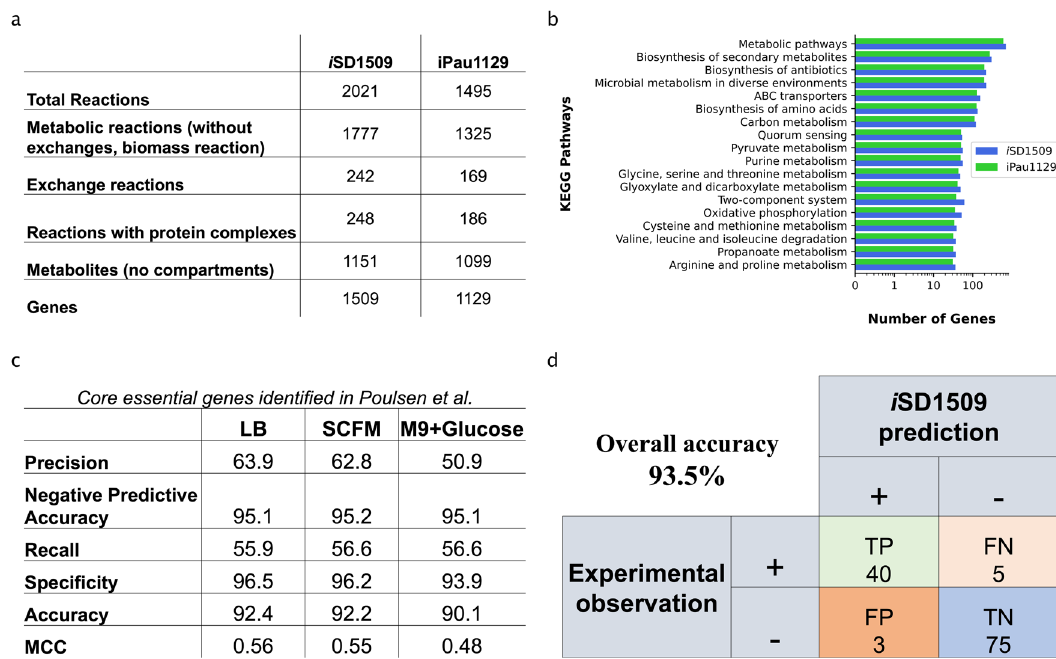
Fig. 1 Genome-scale reconstruction of Pseudomonas aeruginosa PA14, i SD1509 and its predictive assessment. a When compared with iPau1129, the latest model i SD1509 has considerable increase in the reaction, gene, and metabolite content. Please note that i SD1509 contains two biomass reactions: aerobic and anaerobic (thiamine diphosphate (THMPP) removed as one of the constituents). b The top KEGG pathways between both reconstructions were compared, and i SD1509 evidently has higher gene content in almost every top KEGG pathway. c i SD1509 was then used for predicting core essential genes determined in a separate study 39 . The model prediction accuracy was found to be >90% in three different media conditions indicating a highly predictive model. d Using i SD1509, carbon substrate utilization was predicted for a new set of data 40 . The prediction accuracy was computed to be